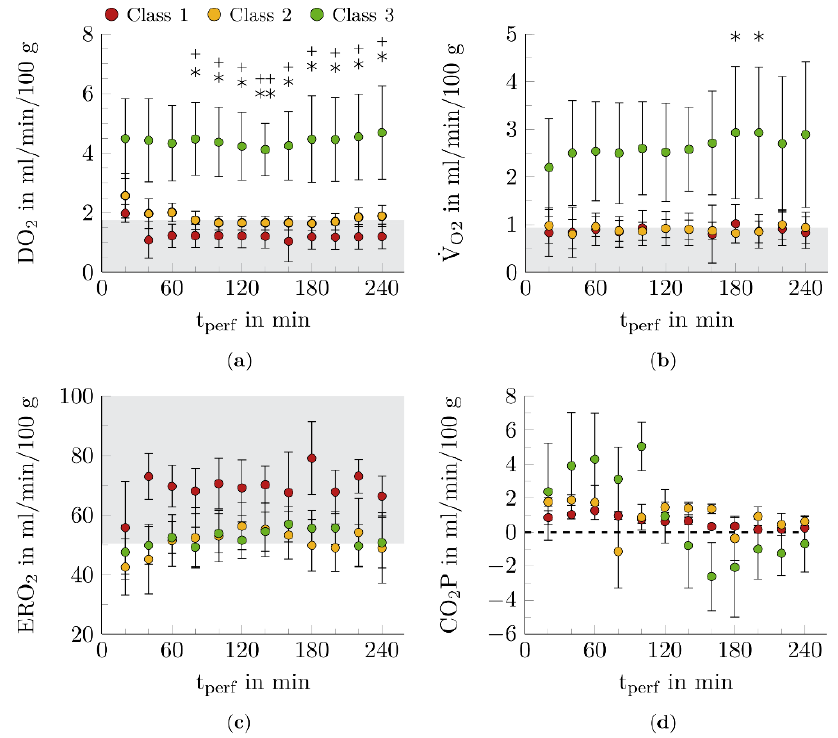
Figure 3. Course of function markers for metabolic activity during NMP. The perfused kidneys showed a correlation between the predicted renal function class and the function markers ( a ) DO 2 , ( b ) VO 2 , ( c ) ERO 2 , and ( d ) carbon dioxide production (CO 2 P). The gray areas illustrate the critical regions of the function markers. The data points represent the twelve times of measurement during the NMP. Shown mean ± SEM. n = 3 for nonfunctional kidneys (class 1), n = 5 – 7 for limited functional kidneys (class 2), n = 9 – 11 for functional kidneys (class 3). *, p < 0.05, **, p < 0.01, class 2 vs. class 3; +, p < 0.05, ++, p < 0.01, class 1 vs. class 3. n < actual number of kidneys per class (see Section 2.3), because unfortunately blood gas analysis could not always be performed for all kidneys at all time points. During NMP, function markers DO 2 , VO 2 , ERO 2 , and CO 2 P varied as a function of renal functional class and perfusion time (t perf ) (see Figure